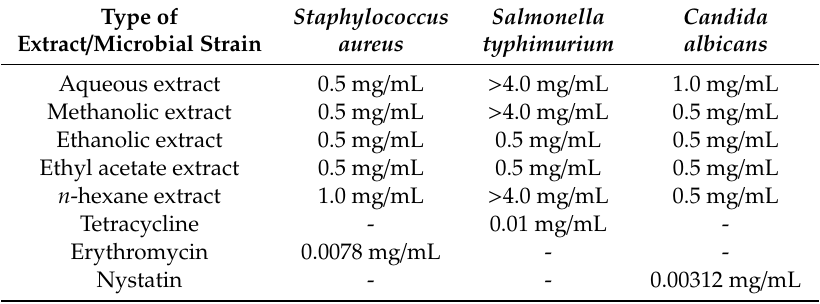
Table 3. The minimum inhibitory concentrations (MICs) of five S. maculatus extracts (aqueous, methanolic, albicans